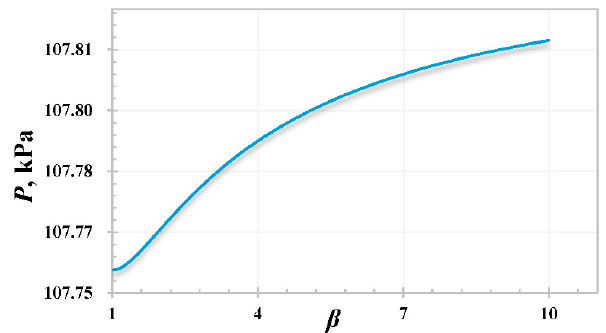
Figure 5. Effect of anisotropy on CBM